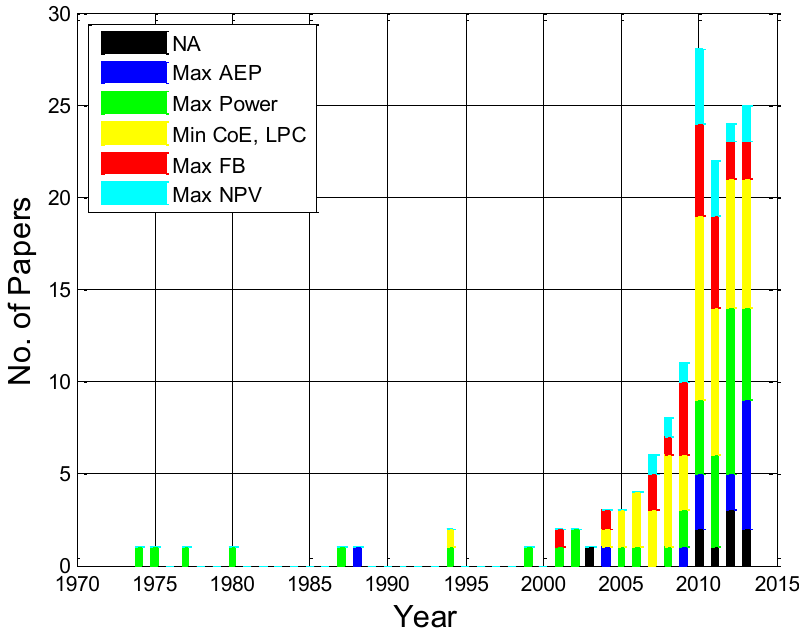
Figure 2. Timeline of Objective Functions used in the WFDO